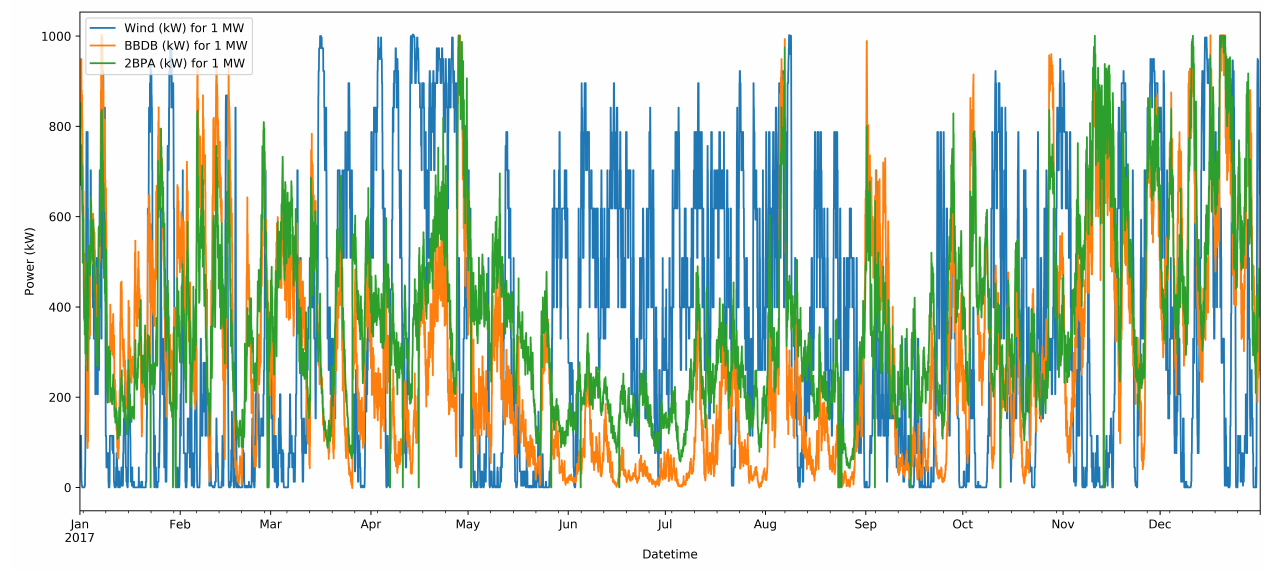
Fig. 1. Annual hourly power production in kW for a 1-MW renewable energy system with wind shown in blue, and marine energy resources shown in orange and